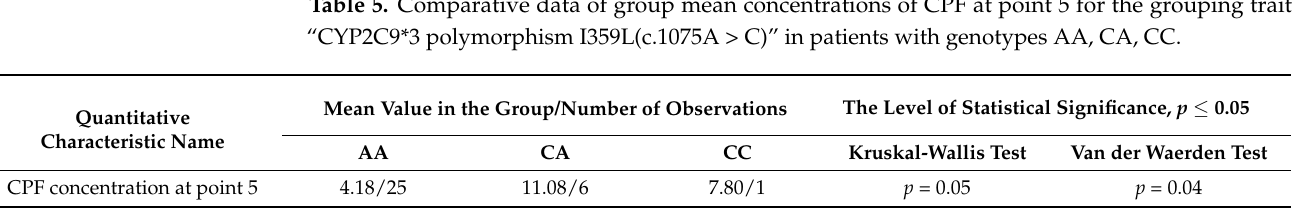
Table 5. Comparative data of group mean concentrations of CPF at point 5 for the grouping trait